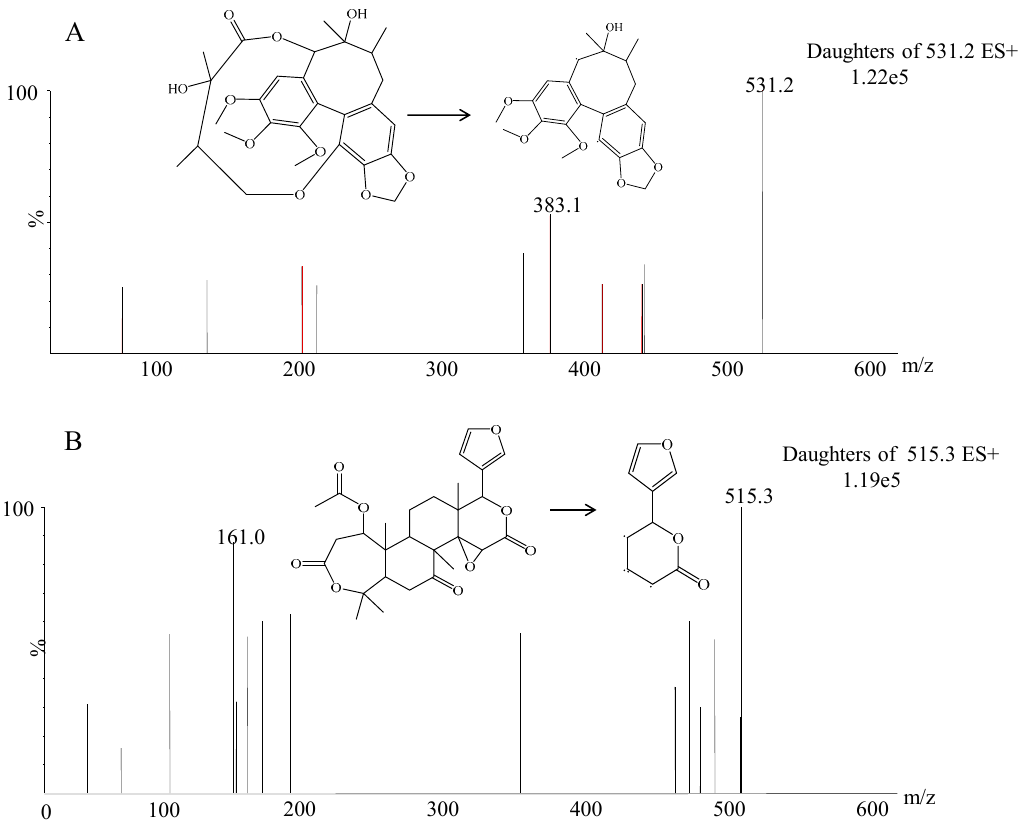
Figure 1. Mass spectra of gomisin D ( A ) and nomilin ( B ) in scan mode with an electrospray ionization (ESI) (+) source.